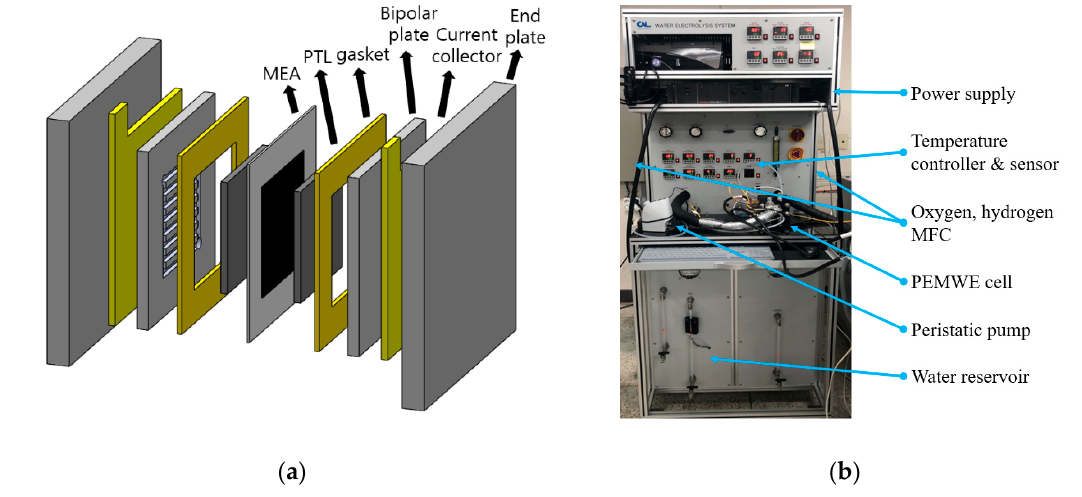
Figure 2. ( a ) Diagram of PEMWE and ( b ) experimental equipment manufactured by the CNL Energy